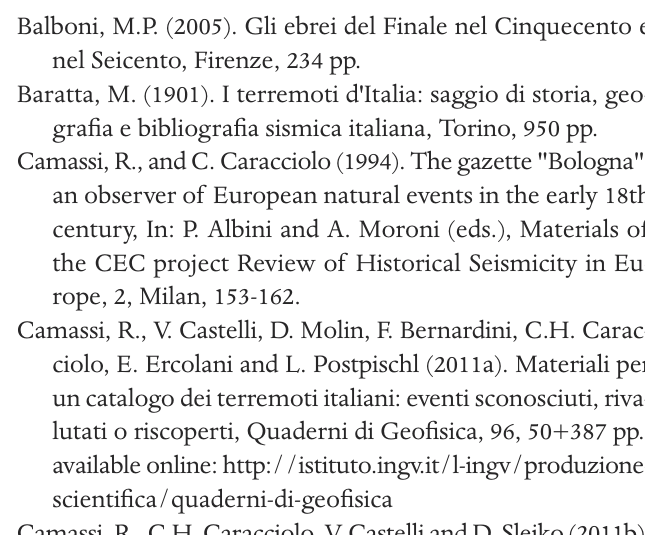
Table 2. Traces of missing local earthquakes retrieved by recent studies.